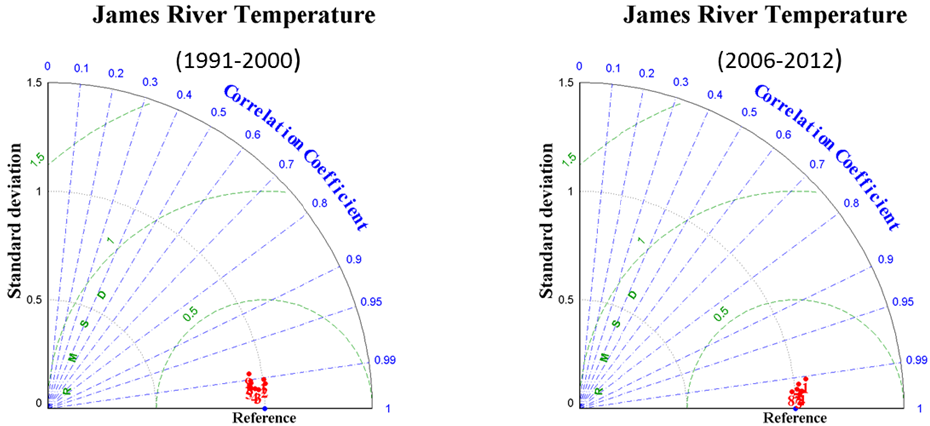
Figure 7. Taylor diagrams representing model-data comparisons at seven monitoring stations in the James River. Station locations: 1 = LE5.5, 2 = LE5.6, 3 = LE5.4, 4 = LE5.3, 5 = LE5.2, 6 = LE5.1, 7 = RET5.2, 8 = TF5.6, 9 = TF5.5, 10 = TF4.5 (reference RMSD value = 8.69 °C).